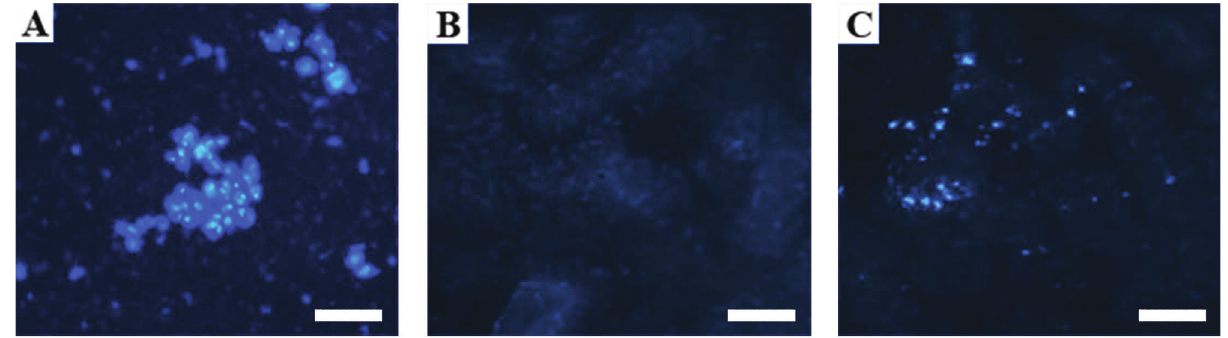
Figure 2 - DAPI staining: (A) MSC stained with DAPI; (B) renal cortex without MSC infiltration; (C) renal cortex with MSC infiltration, 48 h after the transplant. Scale bars: 20 (cid:2)